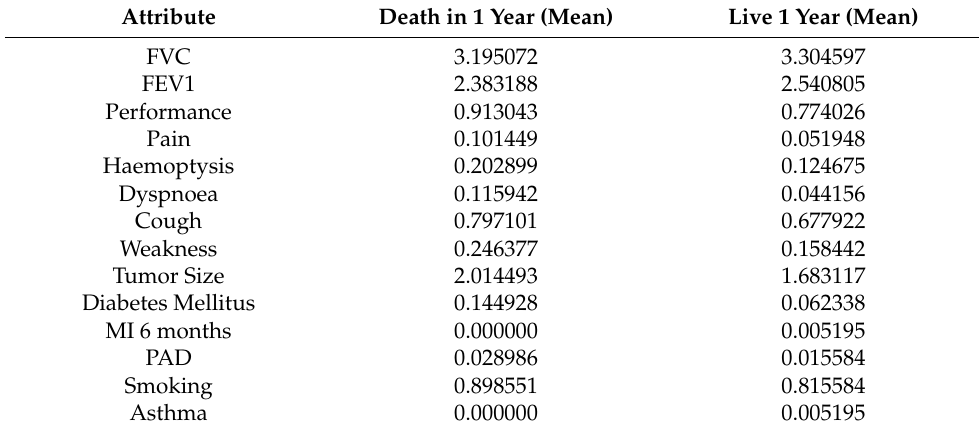
Table 1. Comparison between two separate death and live classes during one